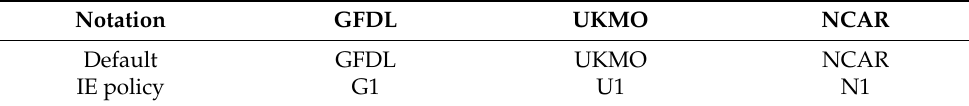
Table 3. Notation of